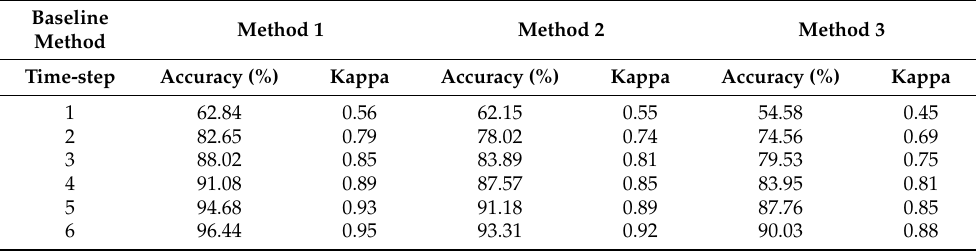
Table 7. Classification results when inputting data at different